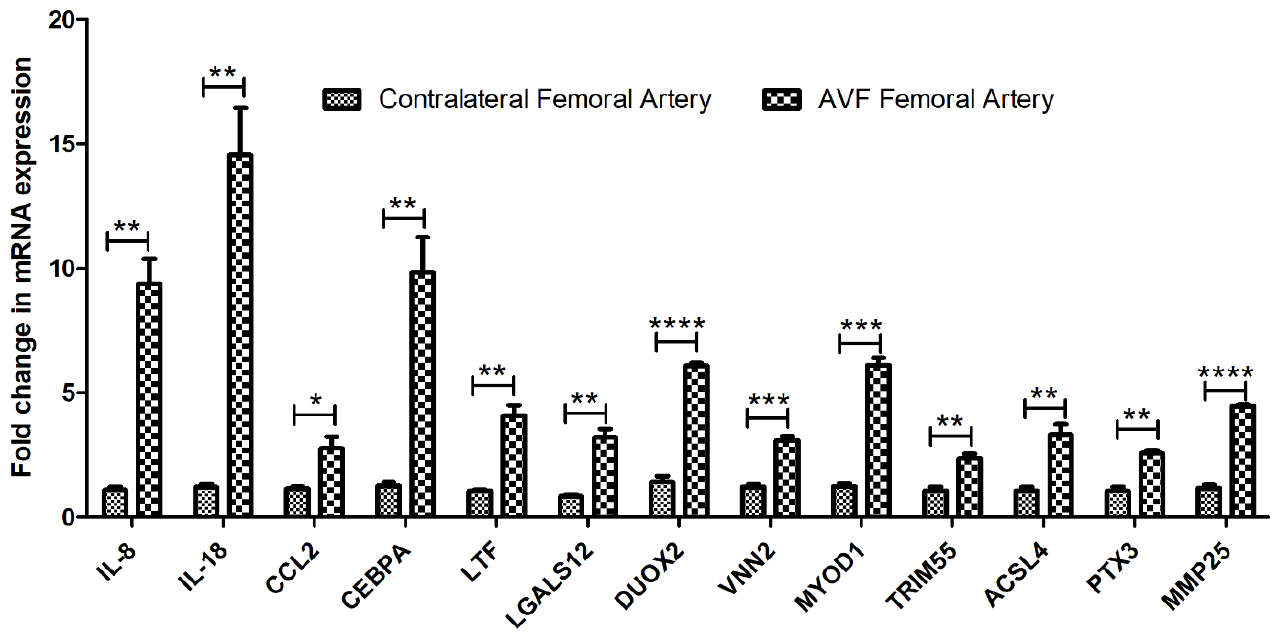
Figure 2. RT-PCR for mRNA expression of DEGs in femoral artery involved in arteriovenous fistula compared to the contralateral femoral artery. All data are presented as mean ± standard deviation (SD). A p -value < 0.05 was considered significant. * p < 0.05, ** p < 0.01, *** p < 0.001, **** p < 0.0001. Interleukin (IL), C-C Motif Chemokine Ligand 2 (CCL2), CCAAT Enhancer Binding Protein Alpha (CEBPA), Lactotransferrin (LTF), Galectin 12 (LGALS12), Dual Oxidase 2 (DUOX2), Vanin 2 (VNN2), Myoblast Determination Protein 1 (MYOD1), Tripartite Motif Containing 55 (TRIM55),